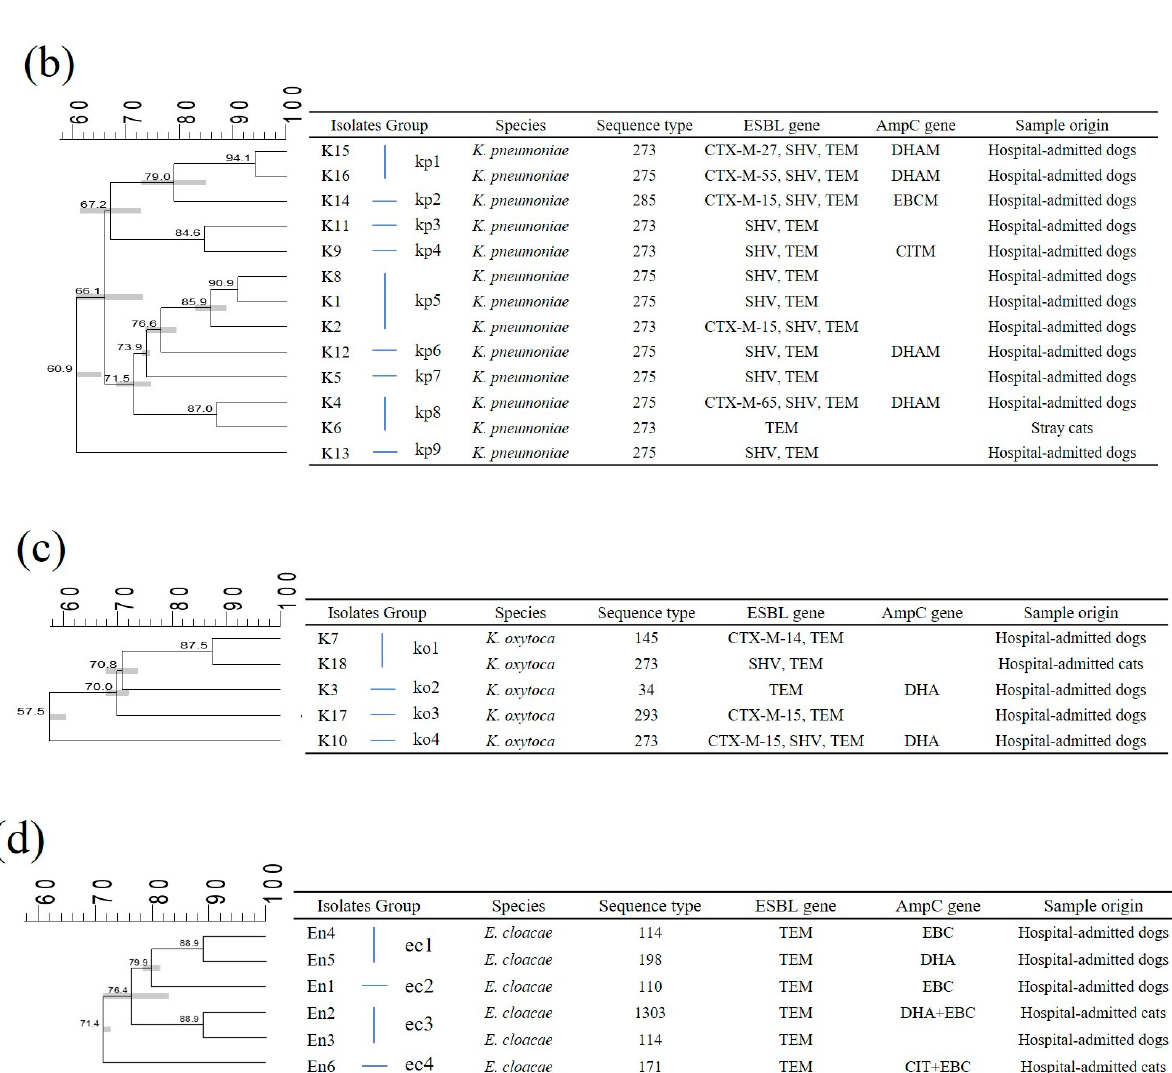
Figure 1. Dendrogram of pulsed-field gel electrophoresis (PFGE) patterns showing the genetic relatedness of ESBL-producing Enterobacterales isolates. ( a ) Escherichia coli , ( b ) Klebsiella pneumoniae , ( c ) K. oxytoca , and ( d ) Enterobacter cloacae